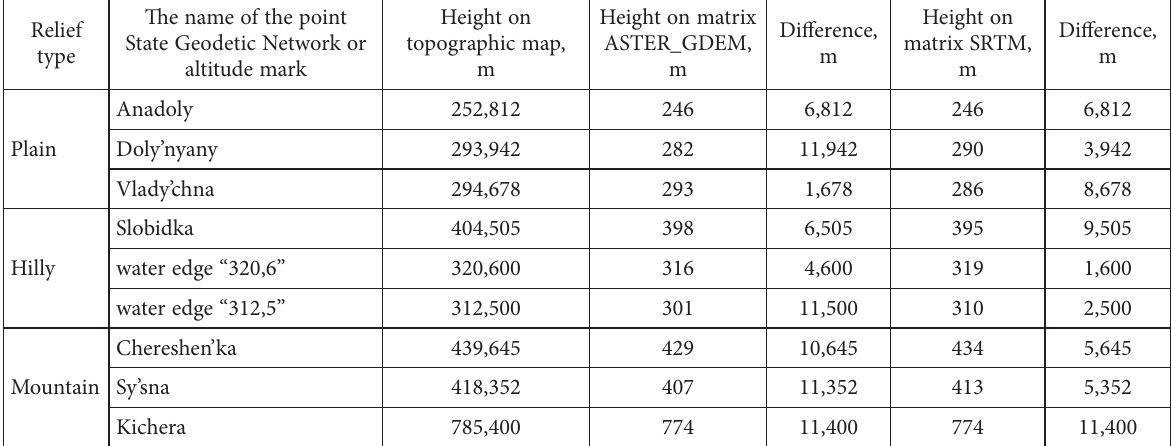
Table 6. Difference of high values of global surfaces with respect to separate markings of topographic maps